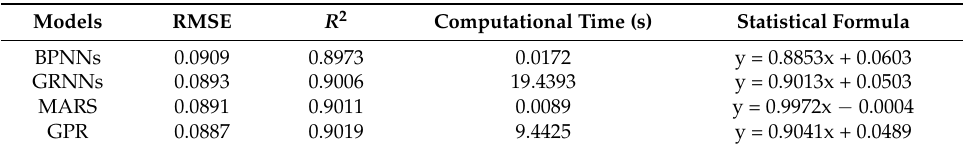
Table 3. The theoretical performances of the four machine learning methods (x and y represent the estimated FVC and GLASS FVC,